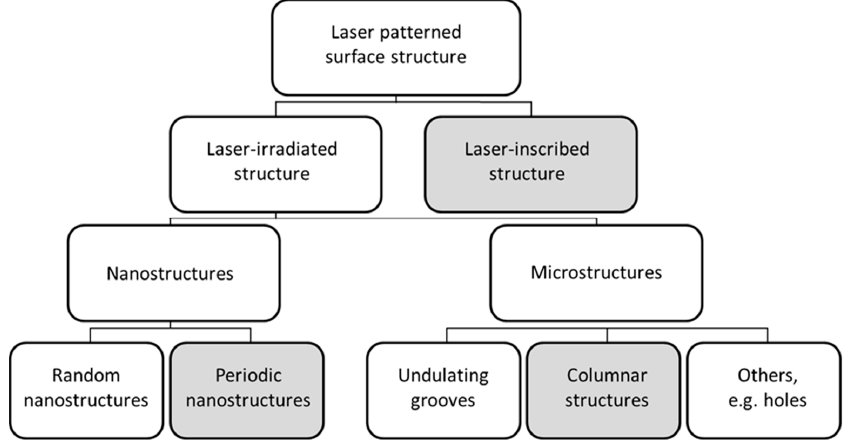
Figure 2. Classification of laser-patterned surface structures; structures that were intensively used for the fabrication of biomimetic liquid-repellent surfaces are marked in gray, modified according to [16].